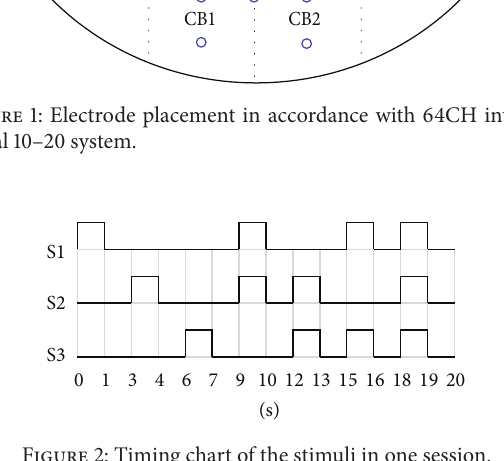
Figure 2: Timing chart of the stimuli in one